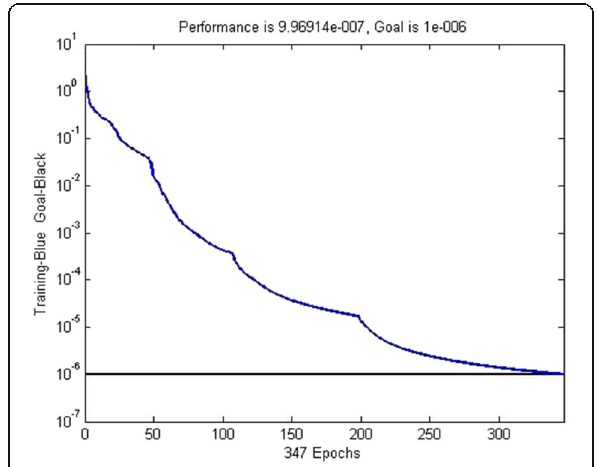
Fig. 14 The relationship between epochs and errors